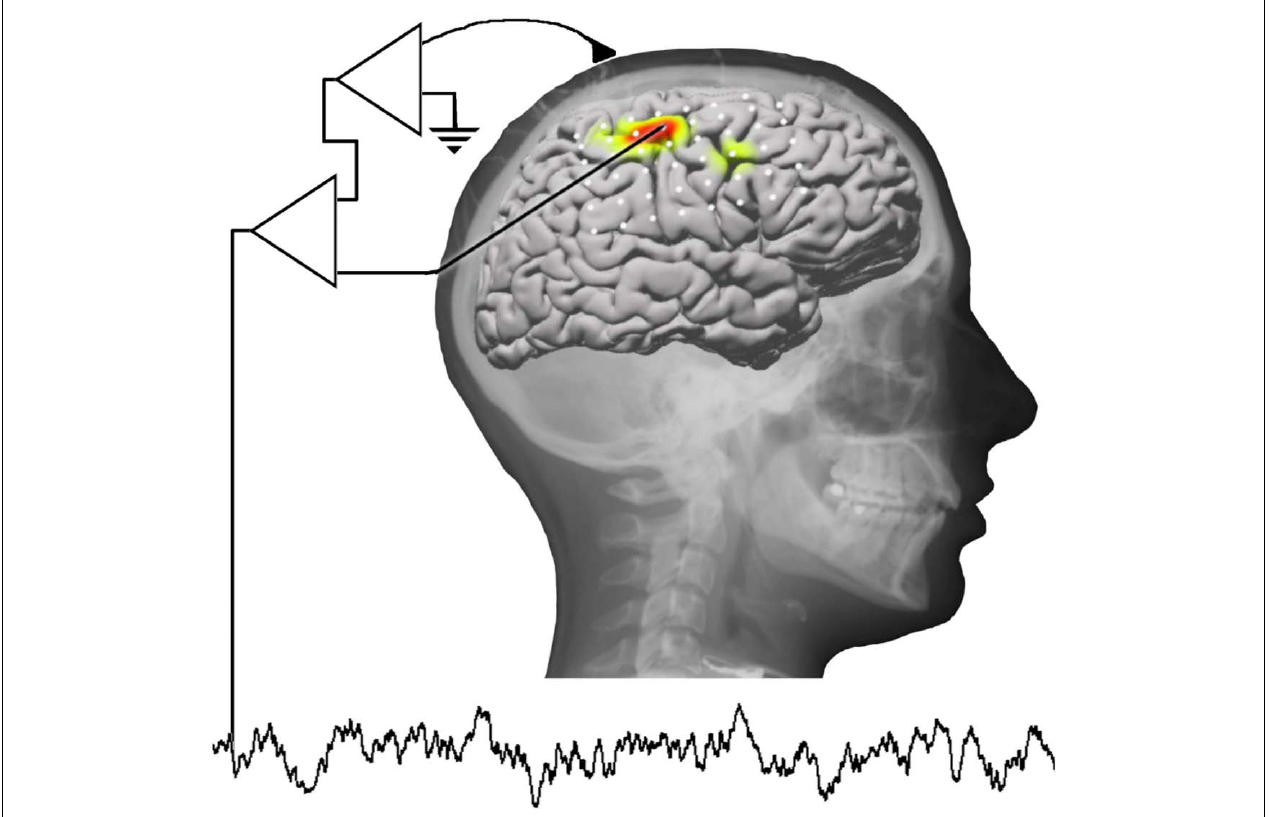
FIGURE 24 | (Data Set 4). The ECoG signals in train_data (time, channel) and test_data (time, channel) were acquired from each electrode with respect to a scalp reference and ground before re-referencing with respect to the common